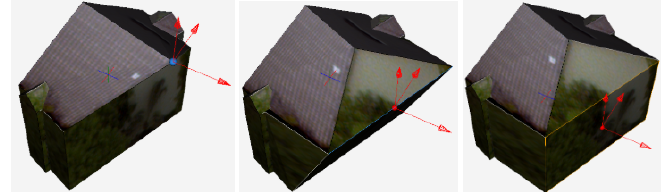
Figure 11. Deformation operations on vertex, edge, and face. Deformation will change f normal , f centroid and f length . A UV space search was performed for these